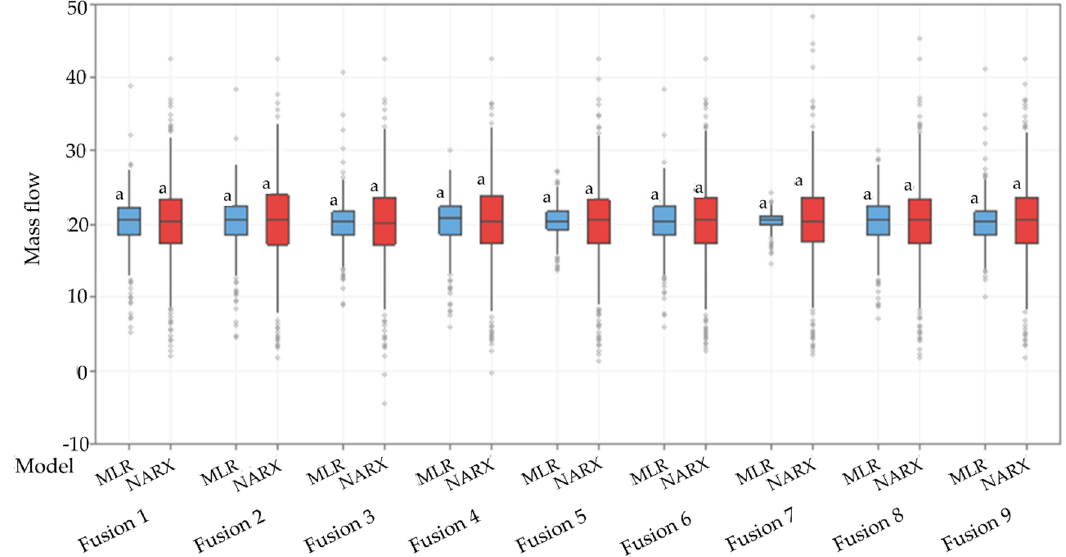
Figure 4. Boxplot of the mass flow (kg s − 1 ) predicted by the models. The same letters above the box indicate no significant difference between the mean mass flow predicted value of the models (Tukey test; p < 0.05). MLR—multiple linear regression (blue box). NARX—nonlinear autoregressive networks with exogenous input (red box). The description of the different fusion models is in Table 2. Table 3. Mass flow prediction assessment metrics of the models tested in this study.